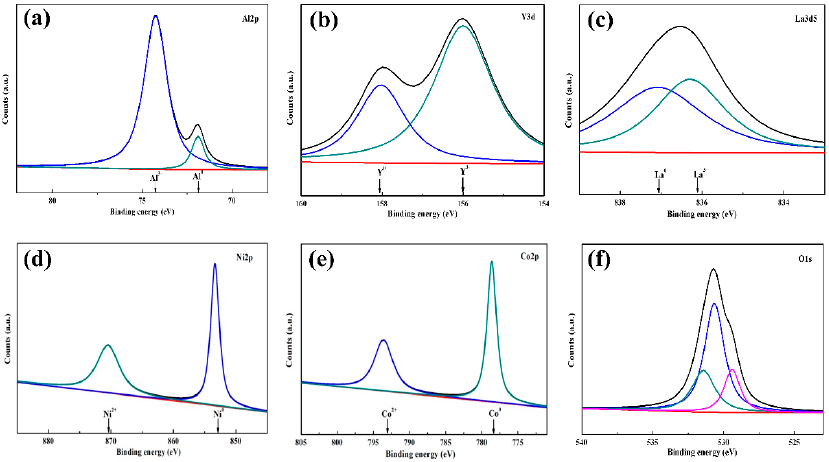
Figure 10. High-revolution spectra of elements of the corroded coated samples ( a ) Al 2p, ( b ) Y 3d, ( c ) La 3d5, ( d ) Ni 2p, ( e ) Co 2p, and ( f ) O 1s.